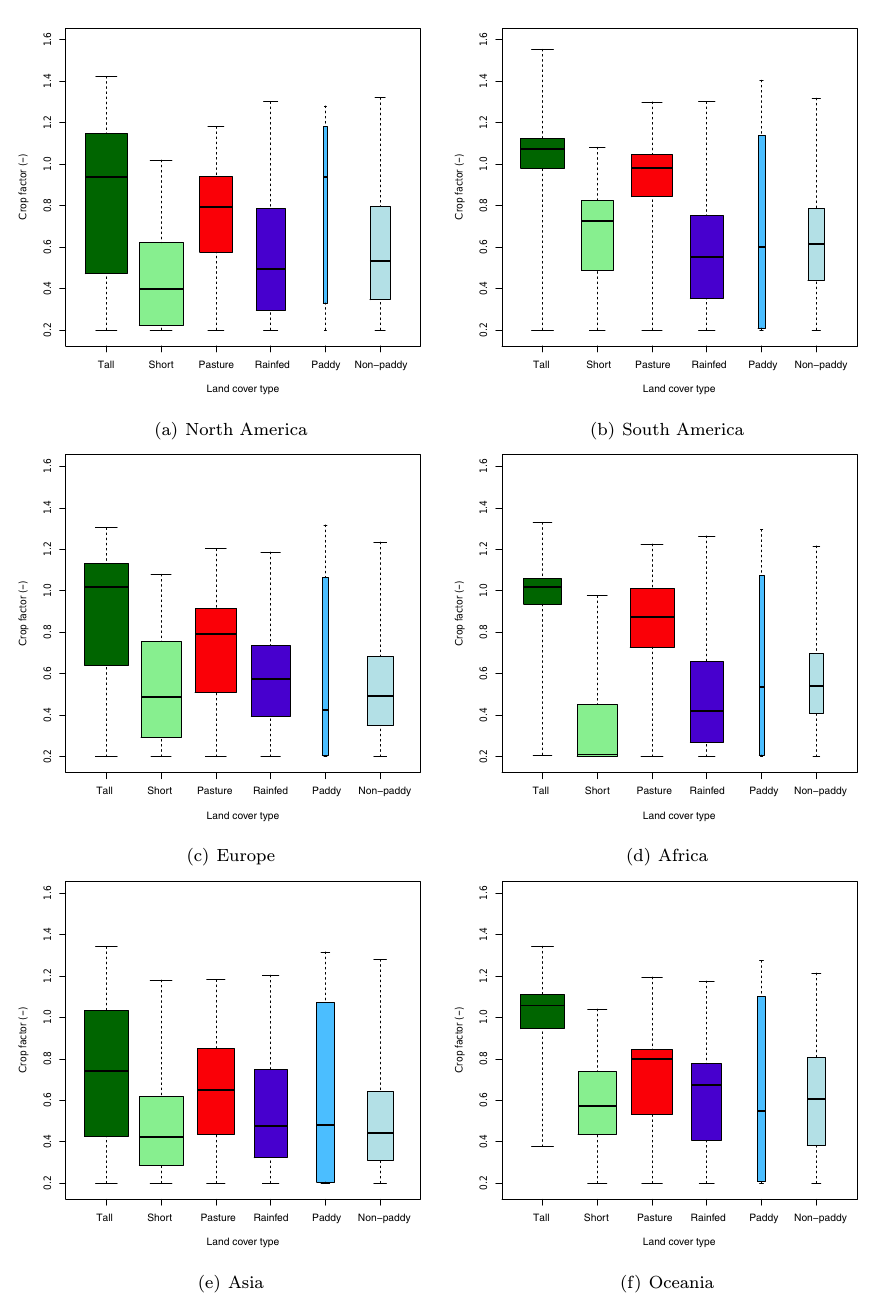
Figure A1. Variation in crop factor ( k c ) in LC2000, used to compute land-cover-specific potential evapotranspiration (ET pot = k c · ET refpot ), per continent and per land cover type. All daily k c values are included. Box plots indicate the minimum and maximum values by the whiskers, the interquartile range (between the first and third quartile) by the box and the median value by the black line within the box. Width of the boxes is proportional to the amount of grid cells within a continent where a land cover type is present. The spread for paddy irrigated crops is high because k c is high during the growing season but rather low (near 0.2) outside the growing season. Continental masks were derived using basins (see Fig. A2), with North and South America separated through central Mexico, Europe and Africa separated through the Arabian Peninsula, Europe and Asia separated through the Ural mountains, and Asia and Oceania separated roughly along the border of Malaysia and